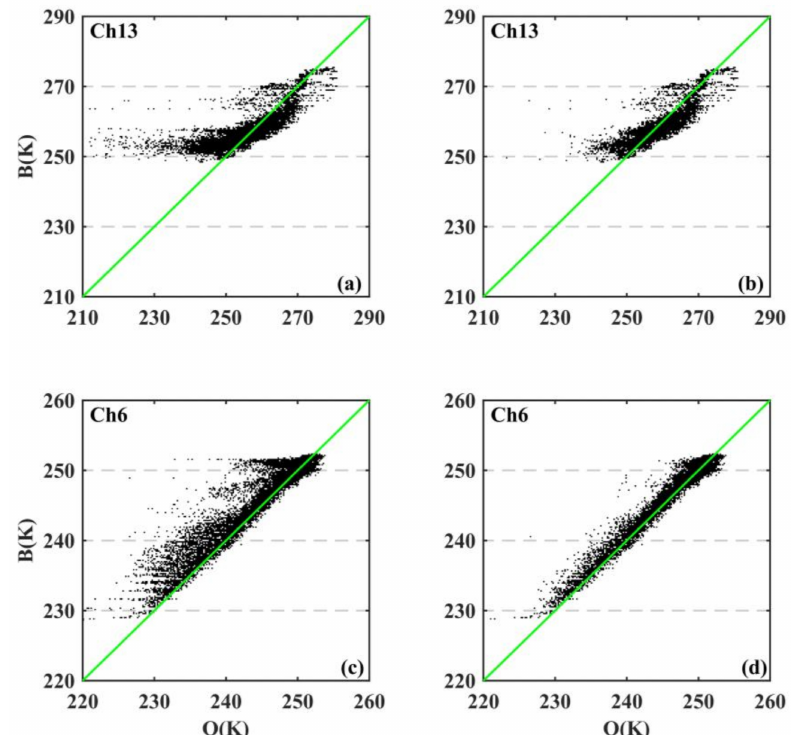
Figure 8. A comparison of B and O before ( a , c ) and after ( b , d ) removing values with radar reflectivity above 15